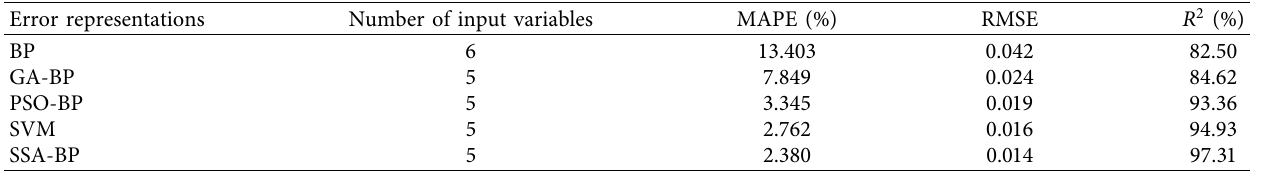
Table 9: Comparison of the results of different models after processing by the MIV